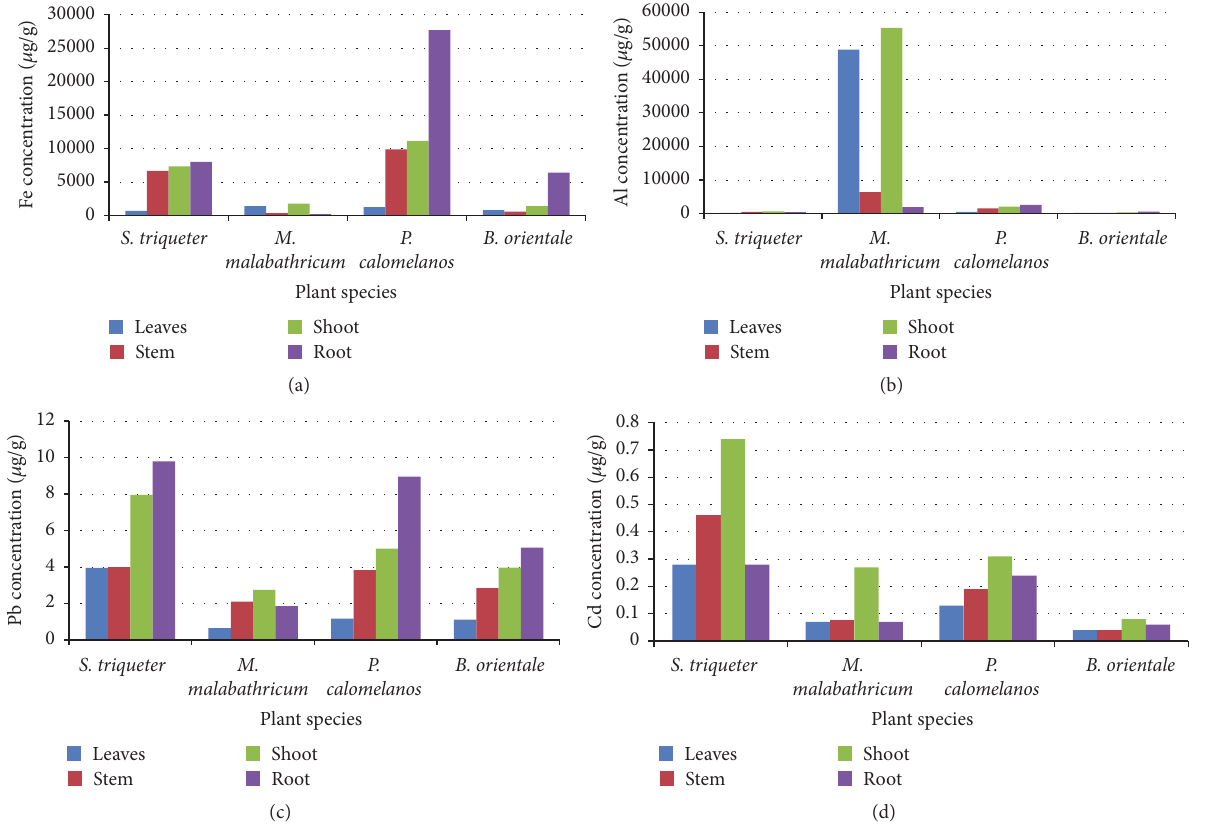
Figure 2: The mean concentrations of heavy metal in different parts (leaves, stem, shoot, and root) of plants species.